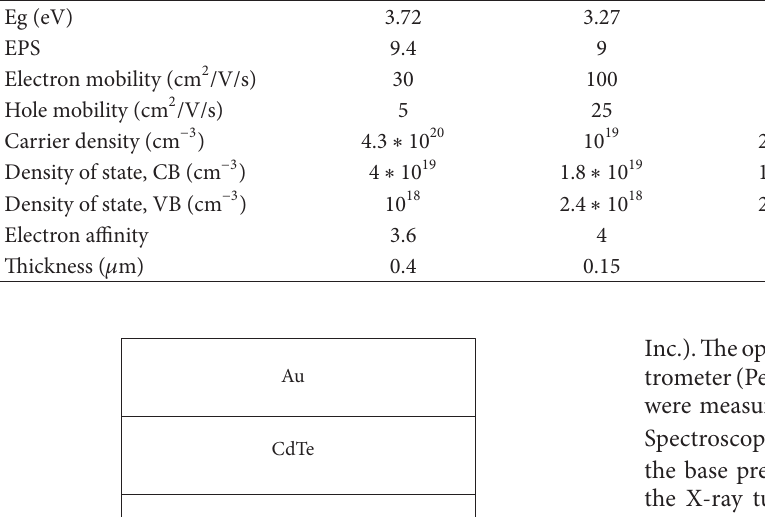
and ITO/ZnO andITO/SnO